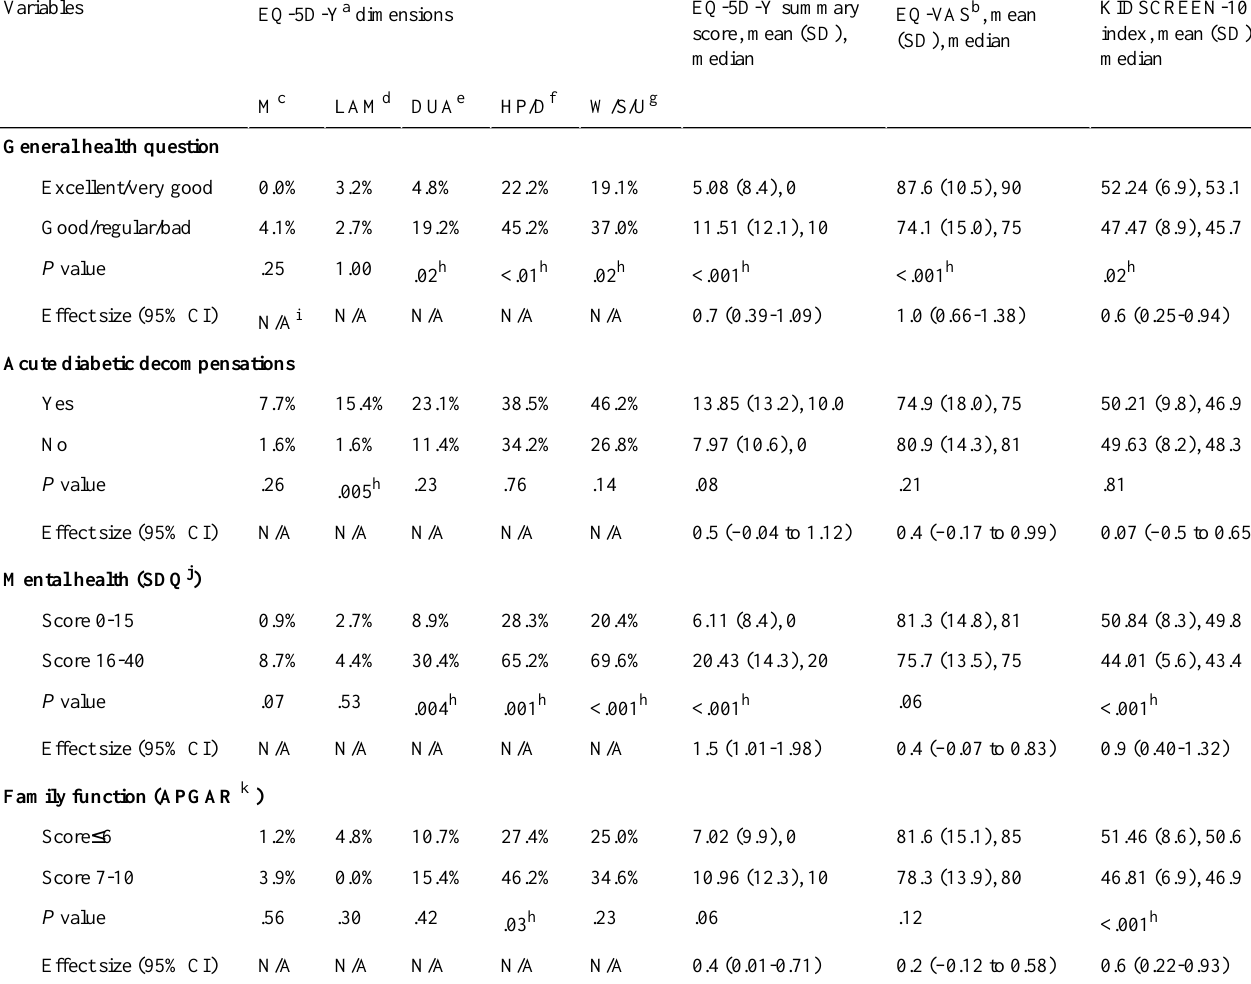
Table 5. Comparison of health-related quality of life between known groups measured at